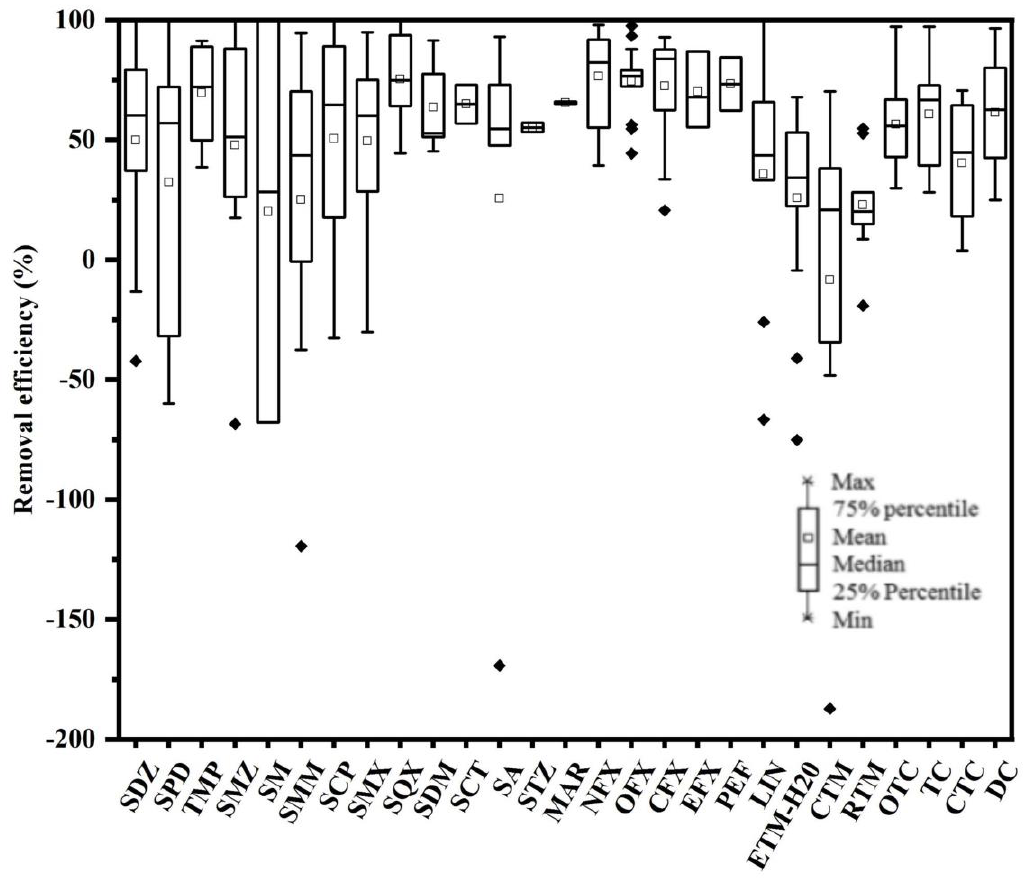
Figure 4. Removal efficiencies of 30 individual antibiotics in the pharmaceutical plants (Abbrevia-